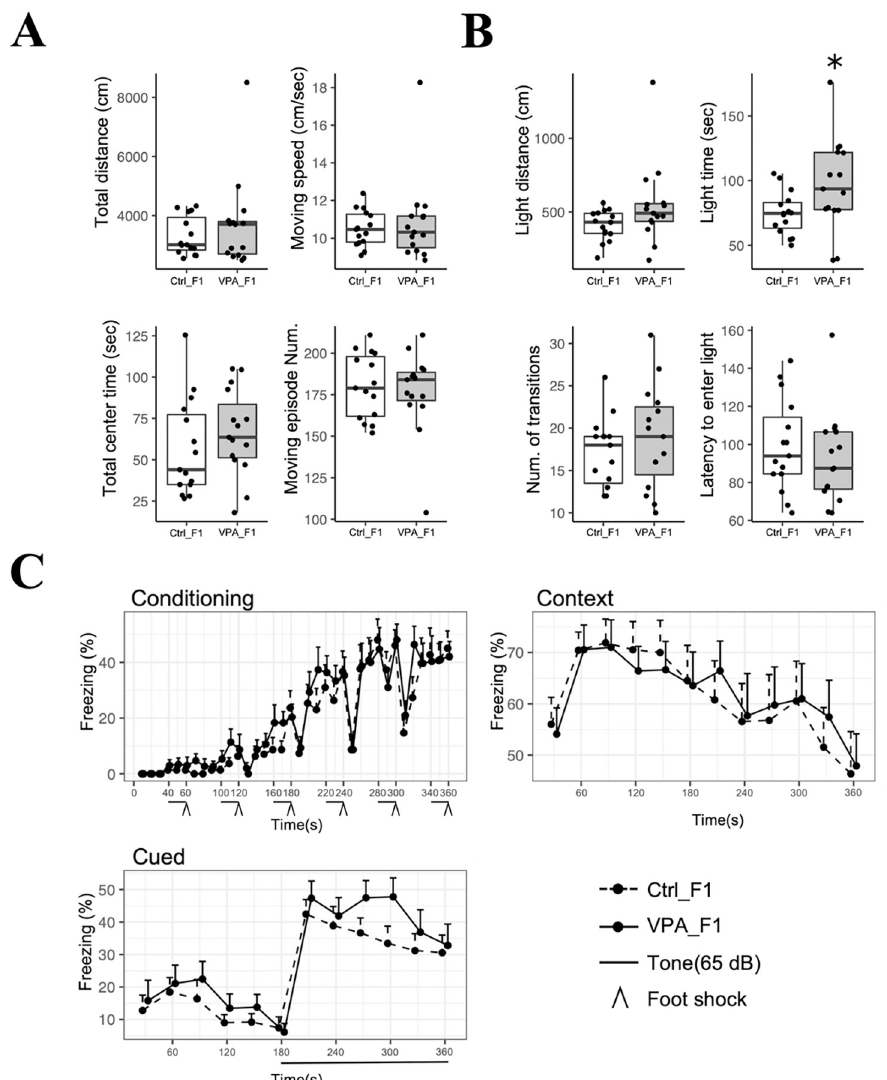
Fig 4. Results of behavioral tests for VPA-treated F1 and control group F1 mice. (A) Results of the open field test are shown in the box-and-whisker plots with overlaid dot plots representing individual data ( � P < 0.05, Student’s t- test, n = 15 per group). The median is marked by a bold line inside the box. The boxes show the 25th–75th percentiles. The whiskers outside the box indicate the range from minimum to maximum values. Data outside the box + 1.5 × interquartile range (IQR) are shown as outliers. Distance traveled (cm), time spent in the center area (sec), average speed (cm/s), and total moving episode number are shown. (B) Results of the light/dark transition test. Distance traveled in the light-box (cm), time spent in the light box (sec), number of times the two boxes have been moved back and forth, time to first enter the light box after the start of the test (sec) are shown. (C) Results of the contextual/cued fear conditioning test expressed as time courses of the freezing scores (%, mean + S.E., n = 15 per group). For the conditioning trial and contextual fear test, the total freezing time was used for statistical analysis by Student’s t-test. For the cued fear test, the total freezing time in the second half (180–360 s) was used.